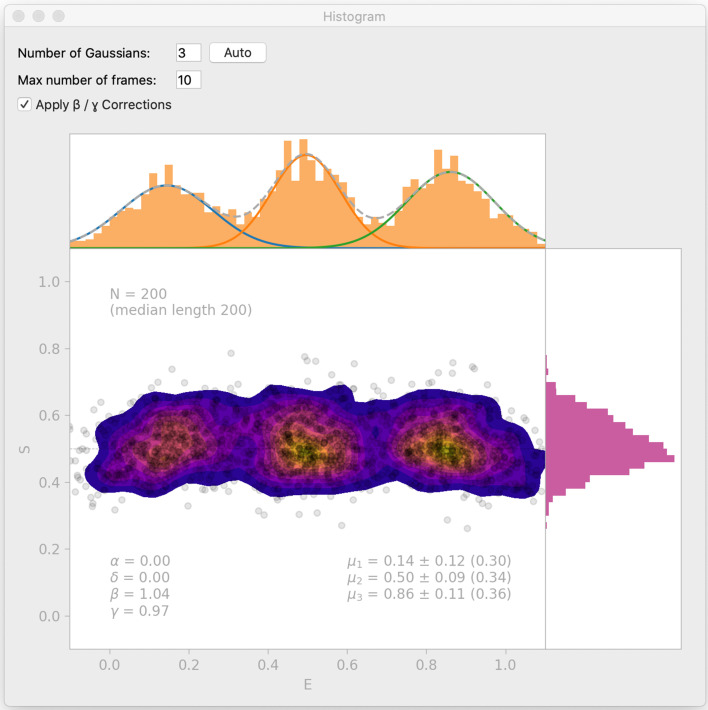
Histogram interface window.DeepFRET includes a histogram window which automatically finds BIC-optimal Gaussian mixtures, and allows the user to test enter the number of Gaussians to include in a mixture model. The histogram interface also includes an option for β- and γ-correction. Data is simulated from DeepFRETs trace generator with three states with means 0.15, 0.5, and 0.85, as in Figure 2—figure supplement 2b.